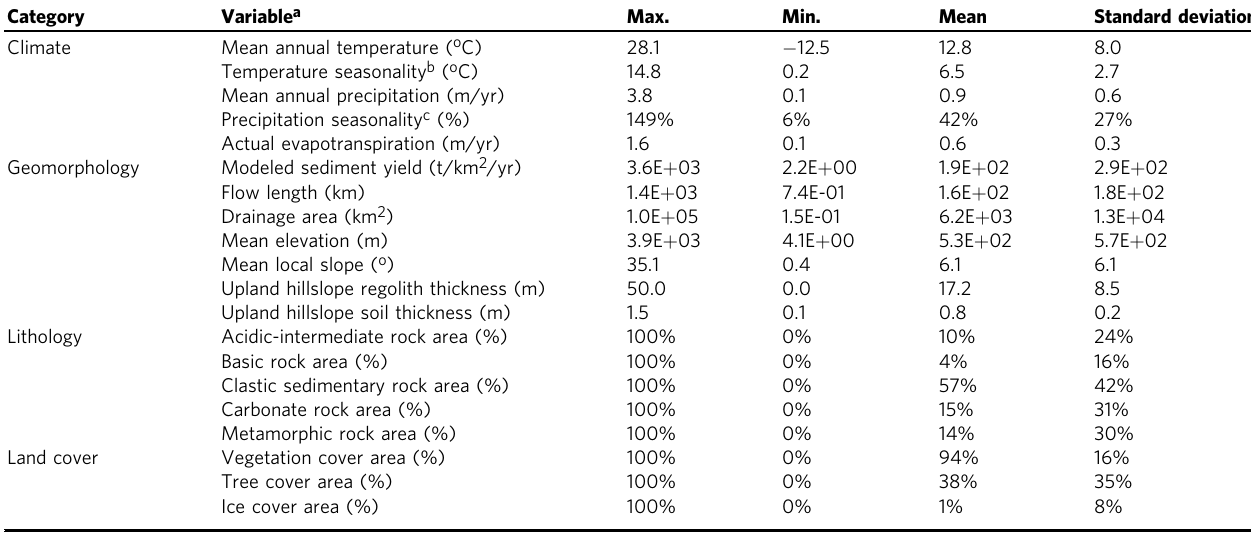
a Dataset of all the variables for each river basin are reported in Supplementary Data 2. b Temperature seasonality is calculated as the standard deviation of monthly temperature. c Precipitation seasonality is calculated as the coef fi cient of variation of monthly precipitation.